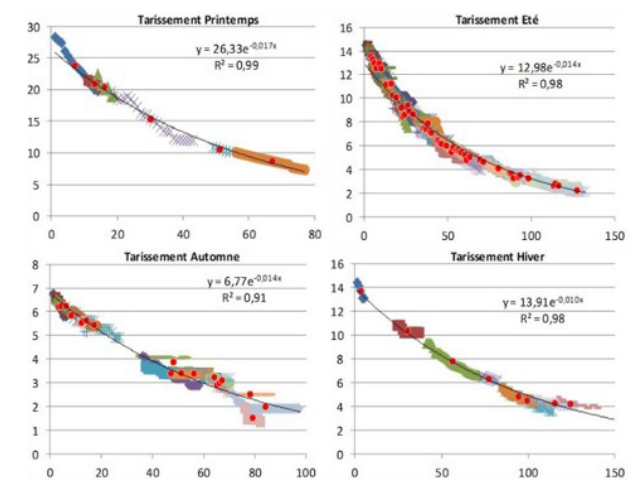
Figure 4. Méthode MSM.